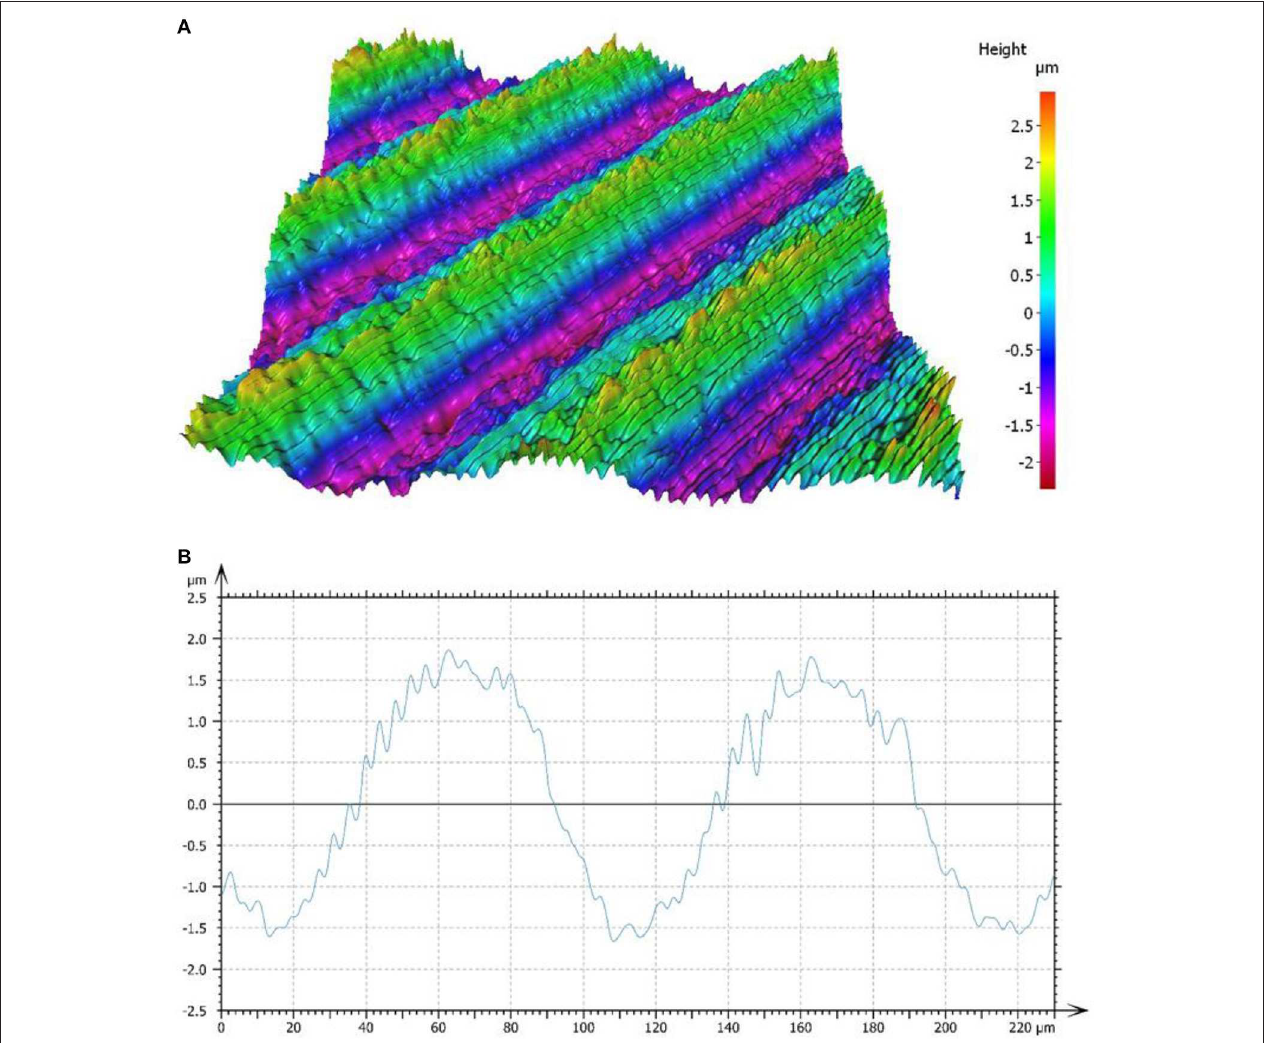
FIGURE 11 | Surface obtained during polarized light measurement—polarization axis set parallel to the order of the pattern (0 ◦ ): (A) 3D surface view and (B) 2D profile.